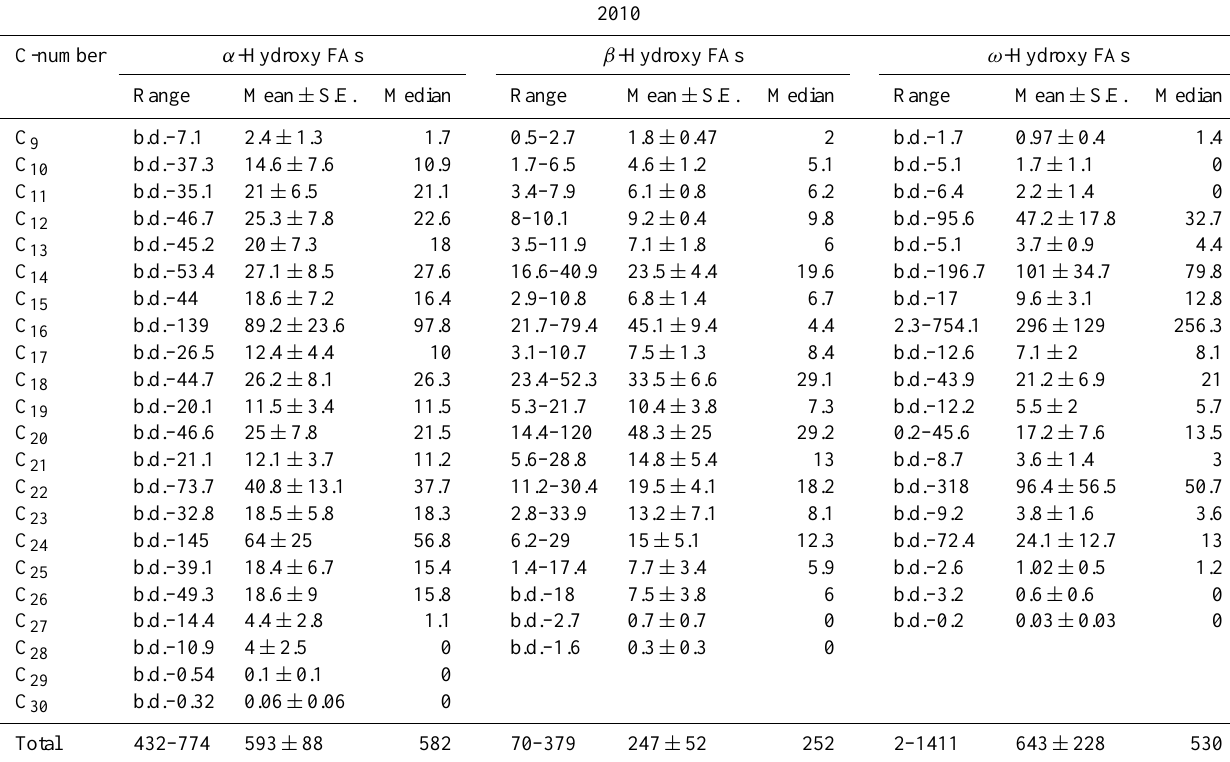
Table 1. Mass concentrations (in ngkg − 1 ) of α -, β - and ω -hydroxy fatty acids (FAs) measured in snow samples ( N = 5) collected from Sapporo during the winter of